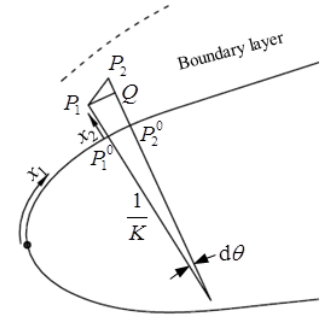
Figure 27. Coordinates for boundary-layer flow along the blade